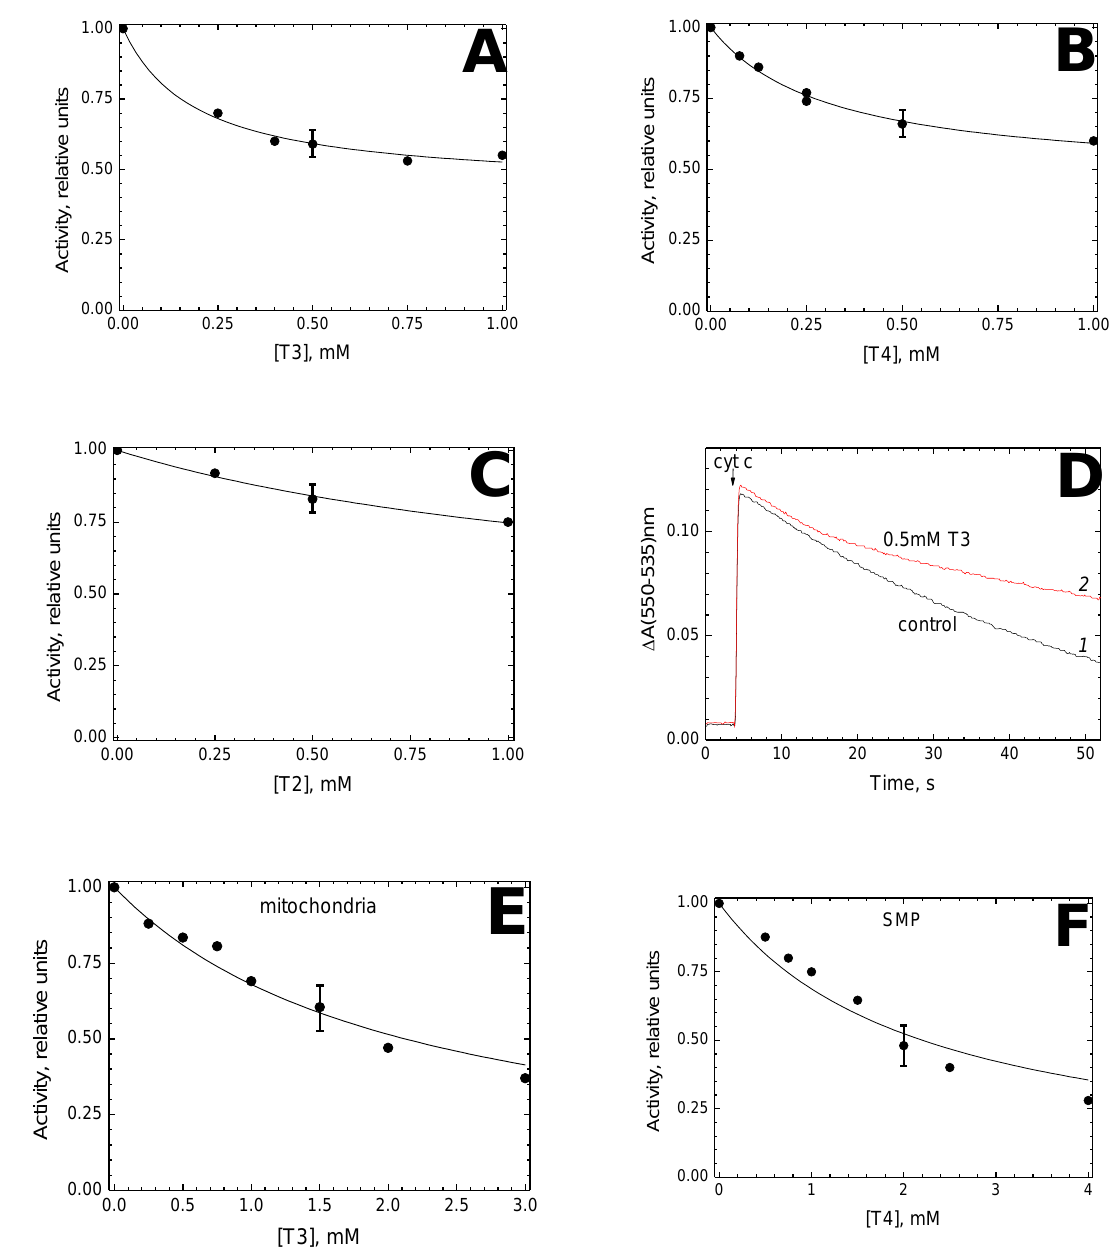
Figure 2. Inhibitory effect of thyroid hormones on the oxidase activity of the membrane-incorporated CcO. ( A – C ) Titration of the oxidase activity of CcO in proteoliposomes by T3 ( A ), T4 ( B ) and T2 ( C ). Proteoliposomes were added to the experimental medium up to 26 nM CcO. The oxidase reaction was initiated by addition of the respiratory substrate. Other details are as in Figure 1B,D. ( D ) T3-induced inhibition of ferrocytochrome c oxidation by CcO in proteoliposomes. The activity was measured in the absence (control curve 1 , black) or in the presence (curve 2 , red) of 0.5 mM T3 in the medium. Other conditions are as in panel ( A ) except that proteoliposomes were added to the medium up to 3.25 nM CcO and pre-incubated for 30 min before adding the respiratory substrate. ( E ) Inhibitory effect of T3 on CcO oxidase activity in rat liver mitochondria. Mitochondria were suspended in the experimental medium up to 0.8 mg of protein/mL. Other details are as in Figure 1B,D. ( F ) Inhibitory effect of T4 on CcO oxidase activity in SMP obtained from bovine heart mitochondria. The conditions were essentially as in panel ( E ) except that the CcO concentration was 20